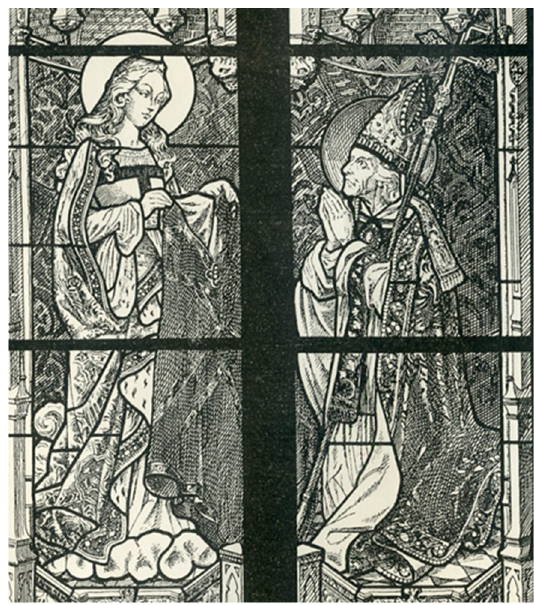
Figure 9. Saint-Lô, Church of Notre-Dame, Saint-Thomas chapel, Life of Saint Thomas window, Figure 9. Saint-L ô , Church of Notre-Dame, Saint-Thomas chapel, Life of Saint Thomas window, 1898, 1898, detail, Mary gifts Thomas a chasuble. © unknown (image in the public domain). detail, Mary gifts Thomas a chasuble. © unknown (image in the public